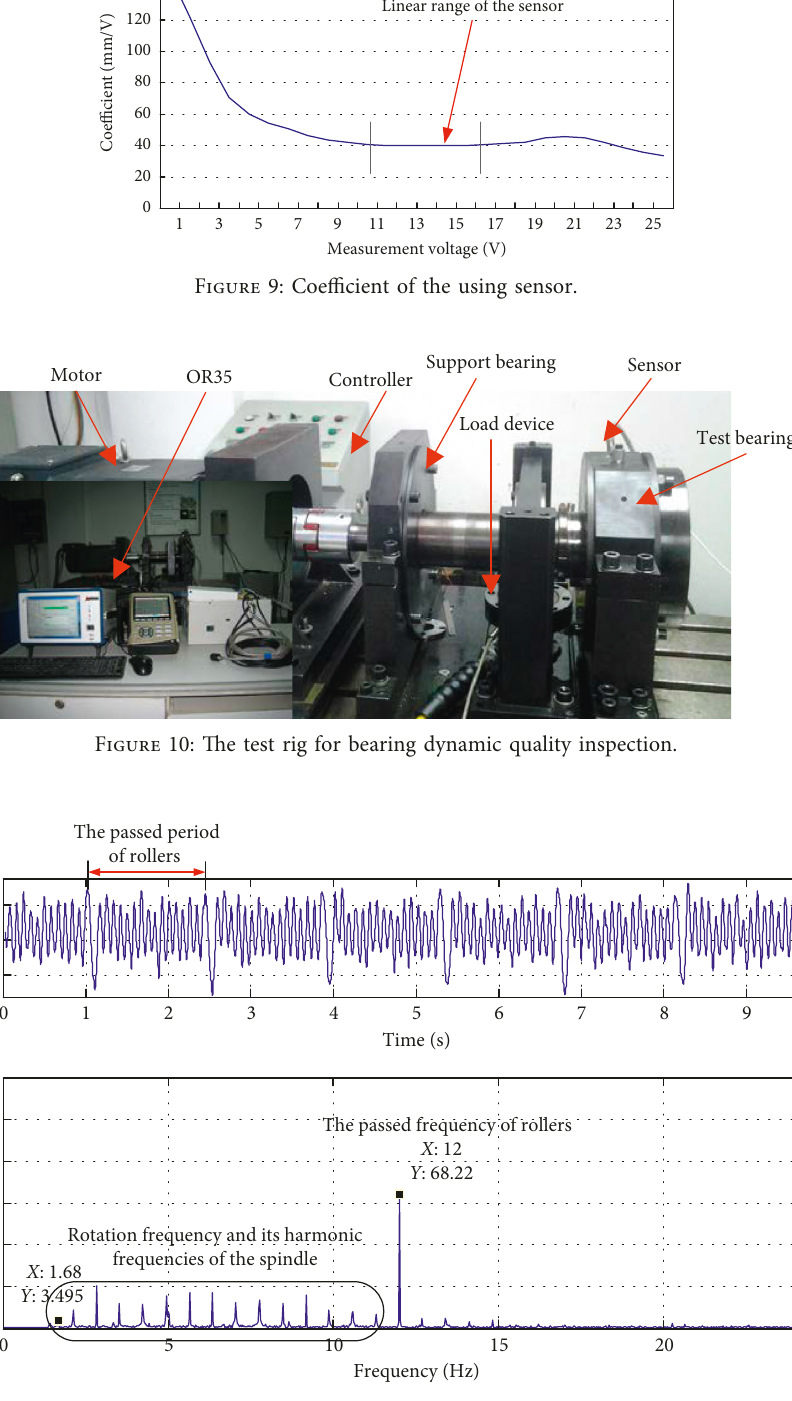
Figure 11: The time-domain diagram and the spectrum diagram of the bearing lack of one roller element.